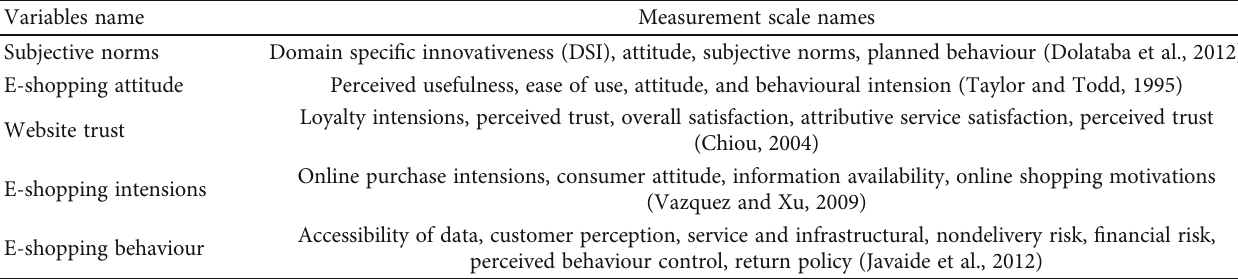
Table 2: Measurement of study variables.